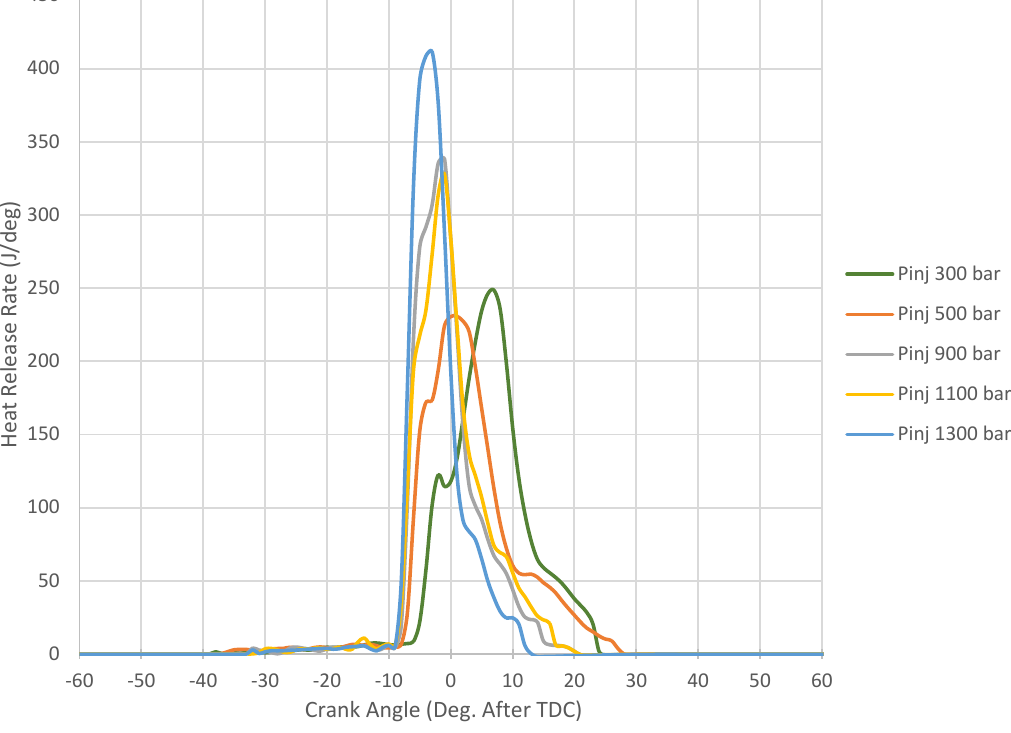
Energies 2019 , 12 , x FOR PEER REVIEW Figure 6. Cylinder pressure versus crank angle (SOI = 17 ◦ BTDC). P inj , pilot fuel injection pressure. Figure 6. Cylinder pressure versus crank angle (SOI = 17° BTDC). P inj , pilot fuel injection pressure.